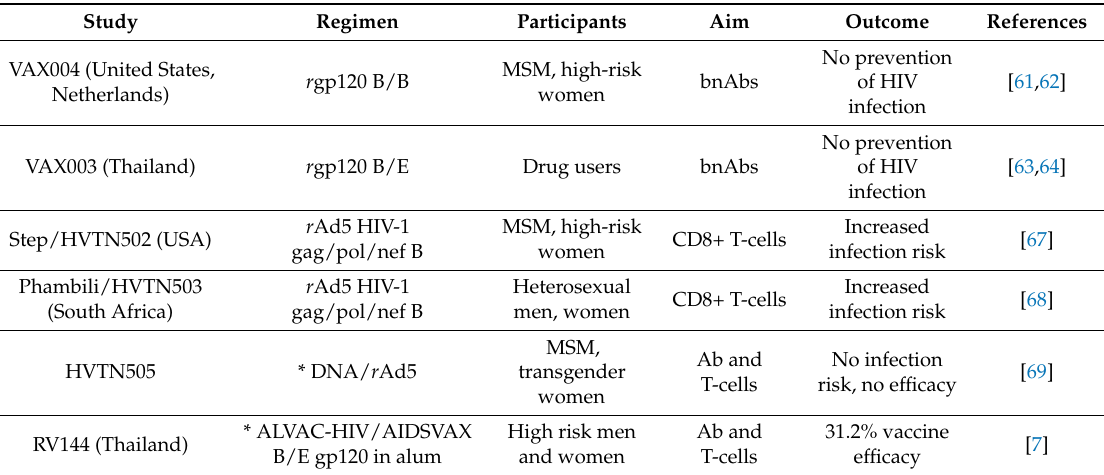
Table 1. HIV clinical trials, rationale design and